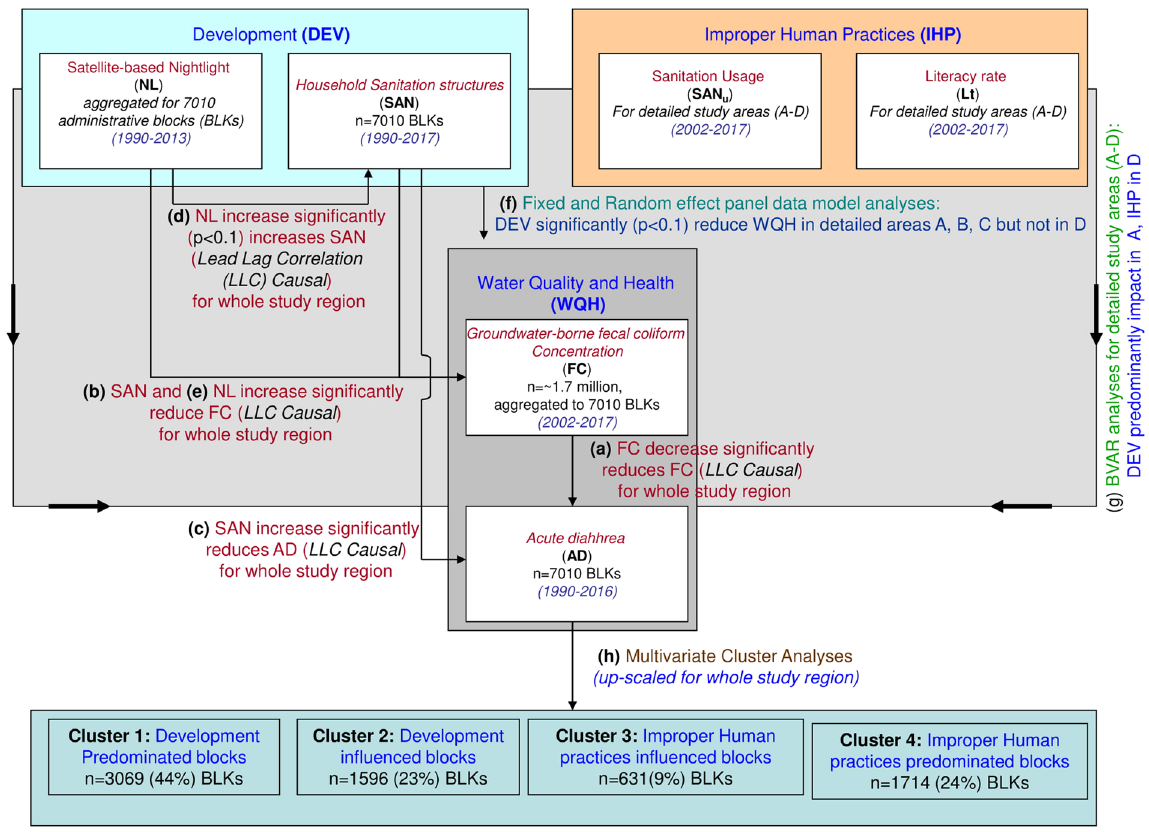
Figure 2. Schematic flowchart of data and methods applied in this study, displaying the parameters that have used e.g. FC, AD, SAN, NL, SAN u , Lt (white boxes) and analyzed relationships [( a ) through ( h )]. The parameters are listed with the numbers of observation and time period used in the study. The relationships also summarize the outcome of the